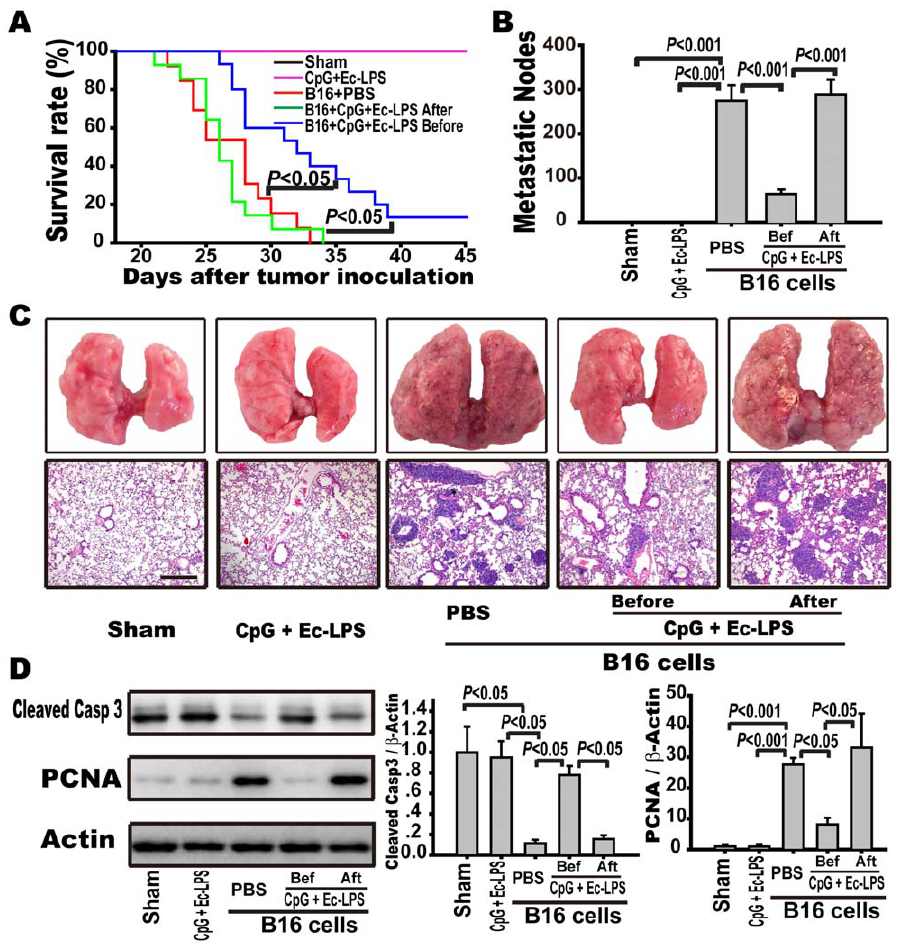
Figure 1. Prophylactic, but not therapeutic, administration of the complex attenuates pulmonary metastasis of B16 melanoma cells. C57BL/6 mice were injected i.v. with B16-F10 melanoma cells (5 6 10 5 /mouse) and administered with the TLR4 agonist EC-LPS (12.5 m g/kg) plus the TLR9 agonist CpG ODN (0.25 mg/kg) i.p. every 3 rd day for 3 doses before (prophylactic group) or after (therapeutic group) tumor cell inoculation. Control animals were treated with PBS or EC-LPS plus CpG ODN with an identical dosage and frequency as indicated in prophylactic group. The